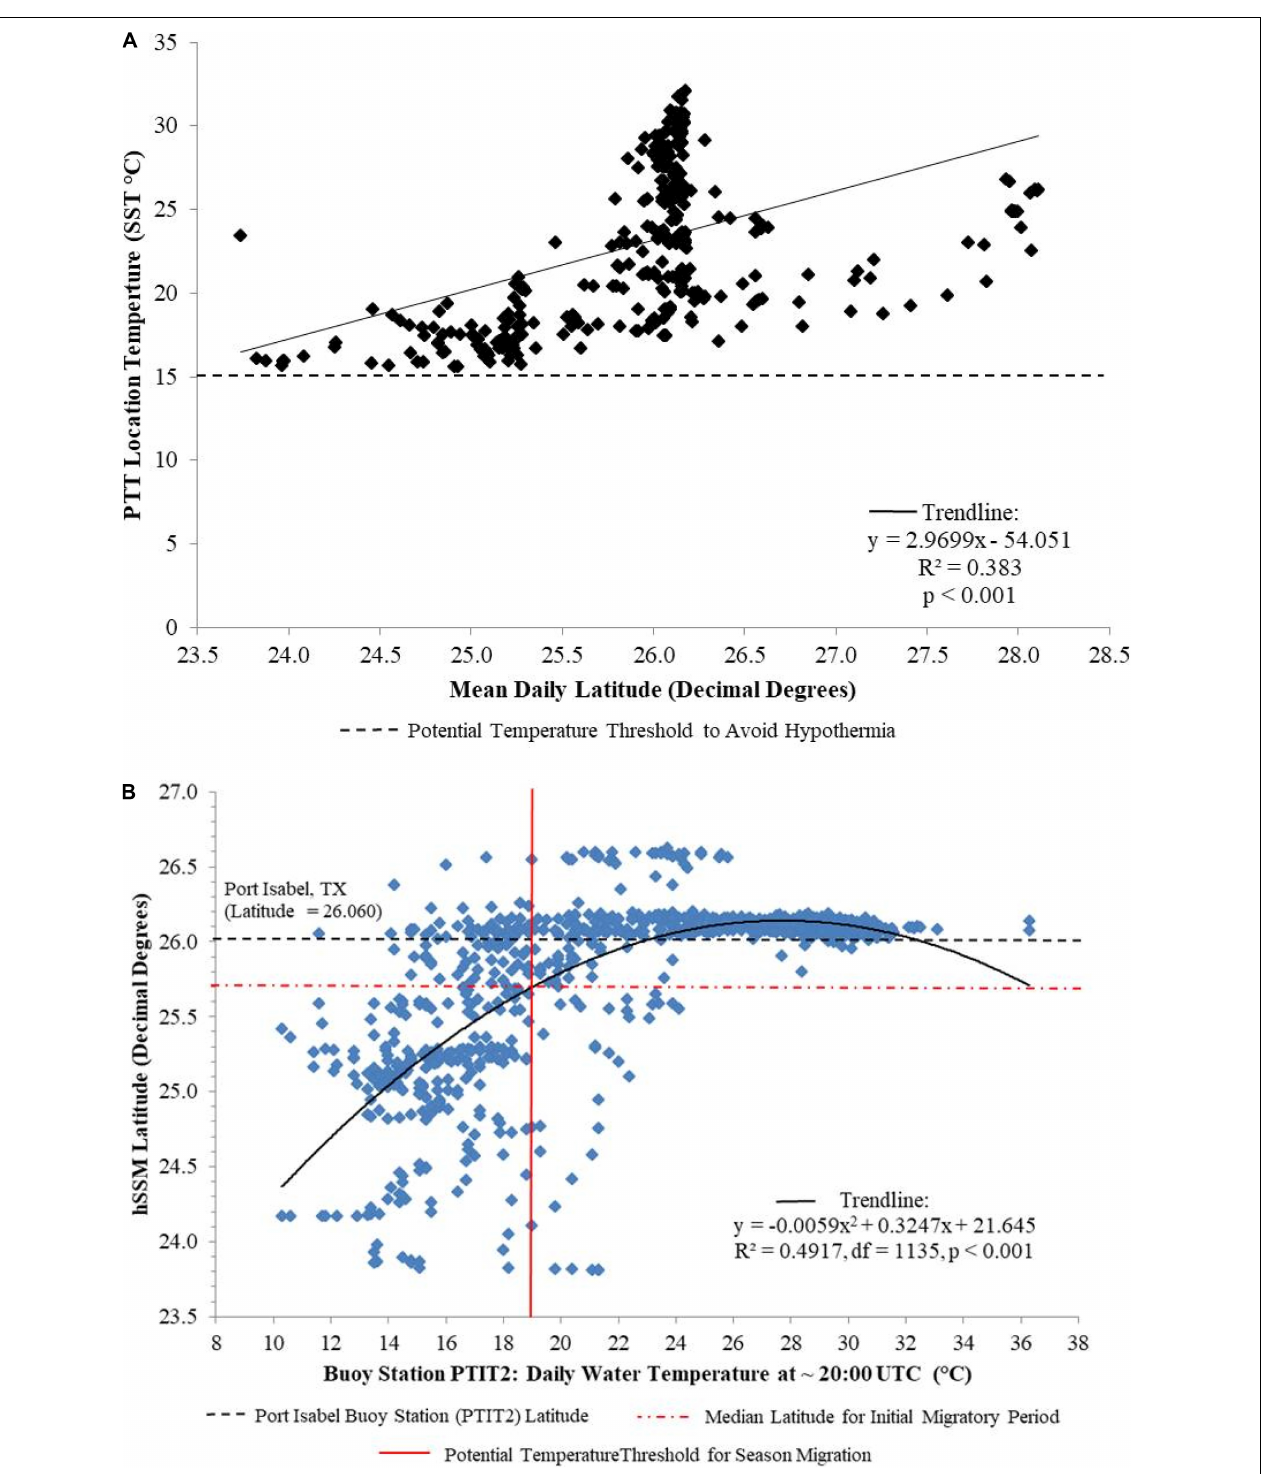
FIGURE 6 | Water temperature associations for juvenile green turtles satellite tracked in the northwestern Gulf of Mexico ( n = 5). (A) Mean daily latitude from raw track data versus satellite tag sea surface temperature (SST). All turtles remained within waters > 15 ◦ C (horizontal dashed line). (B) Mean daily buoy temperature at Port Isabel, TX, United States (latitude = black dashed line) versus mean daily latitude from hSSM data. The intersection between this trend line (solid black line) and mean latitude during the initial migratory period (25.7 ◦ N, red dotted line) coincides with a water temperature near 19 ◦ C (red solid line).